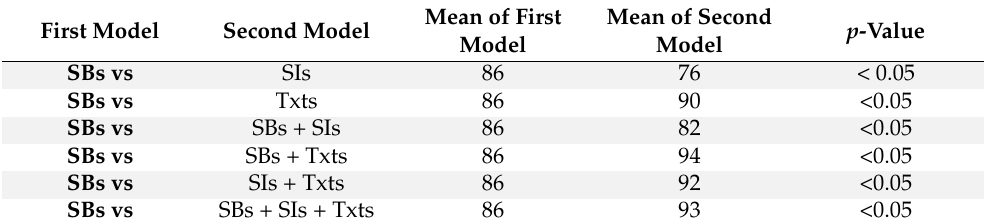
Table 4. Two sample t -tests for the mapping of informal settlements and their p